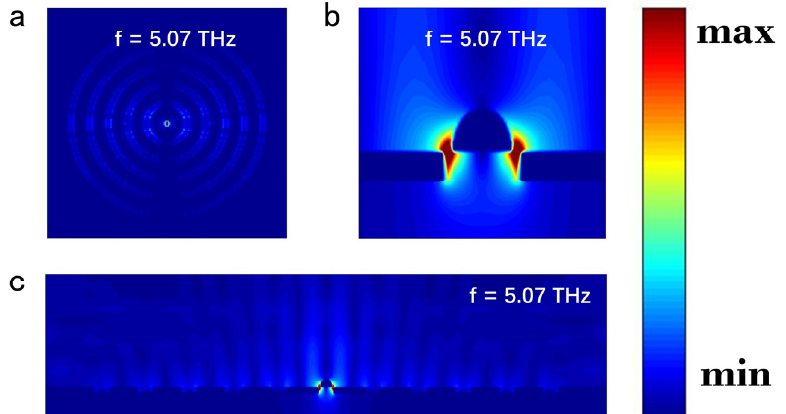
Figure 5. Electric field distributions of the HIHB structure at 5.07 THz. ( a ) Top view of the electric field distribution observed at the film’s surface; ( b ) electric field intensity distribution near the aperture; ( c ) electric field intensity distribution in the cross section of the proposed structure.